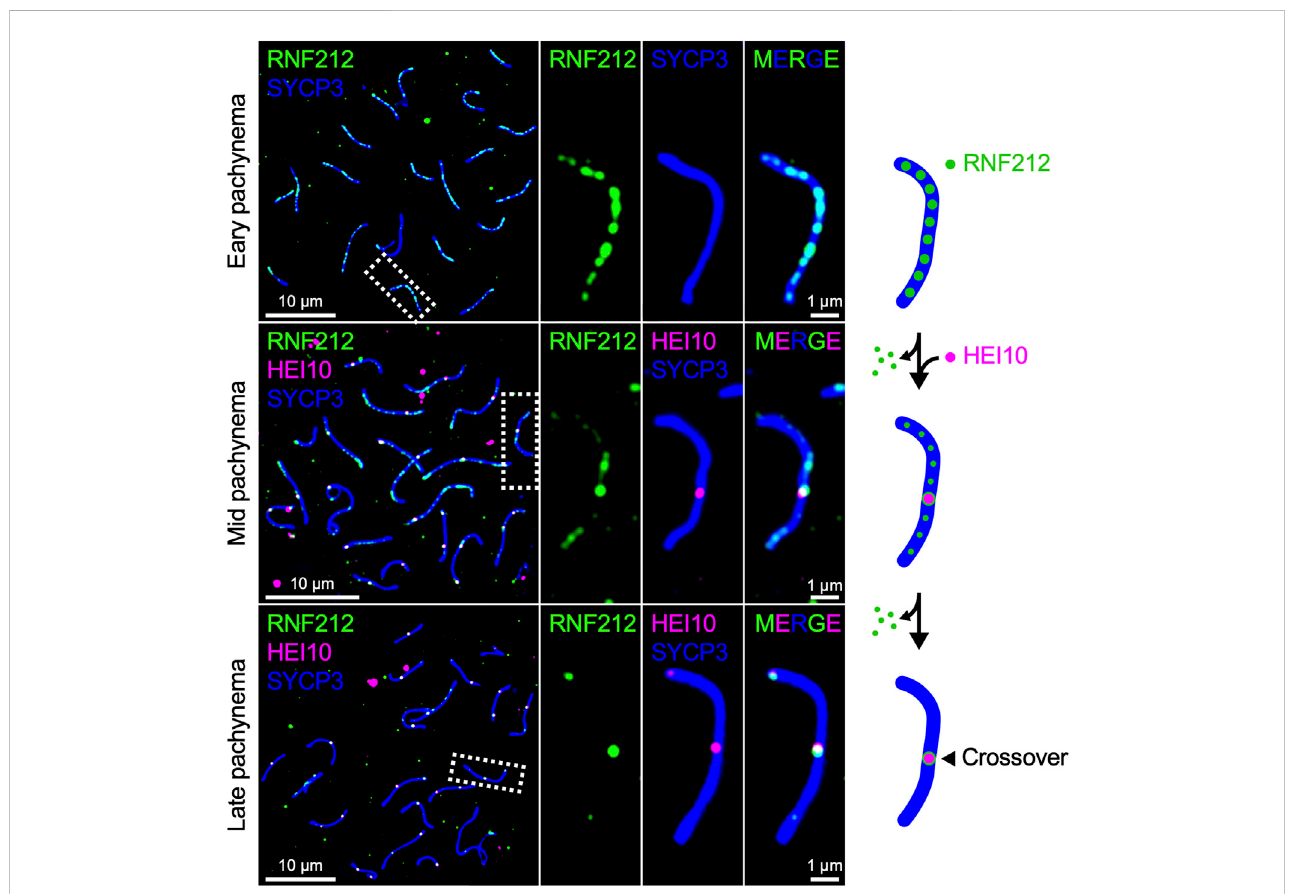
FIGURE 3 Chromosomal localization of RNF212 and HEI10 in mice. Successive stages of mouse pachytene spermatocytes immunostained for RNF212 (green), HEI10 (magenta), and SYCP3 (blue), HEI10 and SYCP3. RNF212 forms numerous discrete foci along the entire SCs (marked by SYCP3) in early pachynema before HEI10 fociemerge (top),loses mostoffoci but accumulates atHEI10-bound crossover sites inmid pachynema (middle),and eventuallyisrestricted to crossover sites in late pachynema